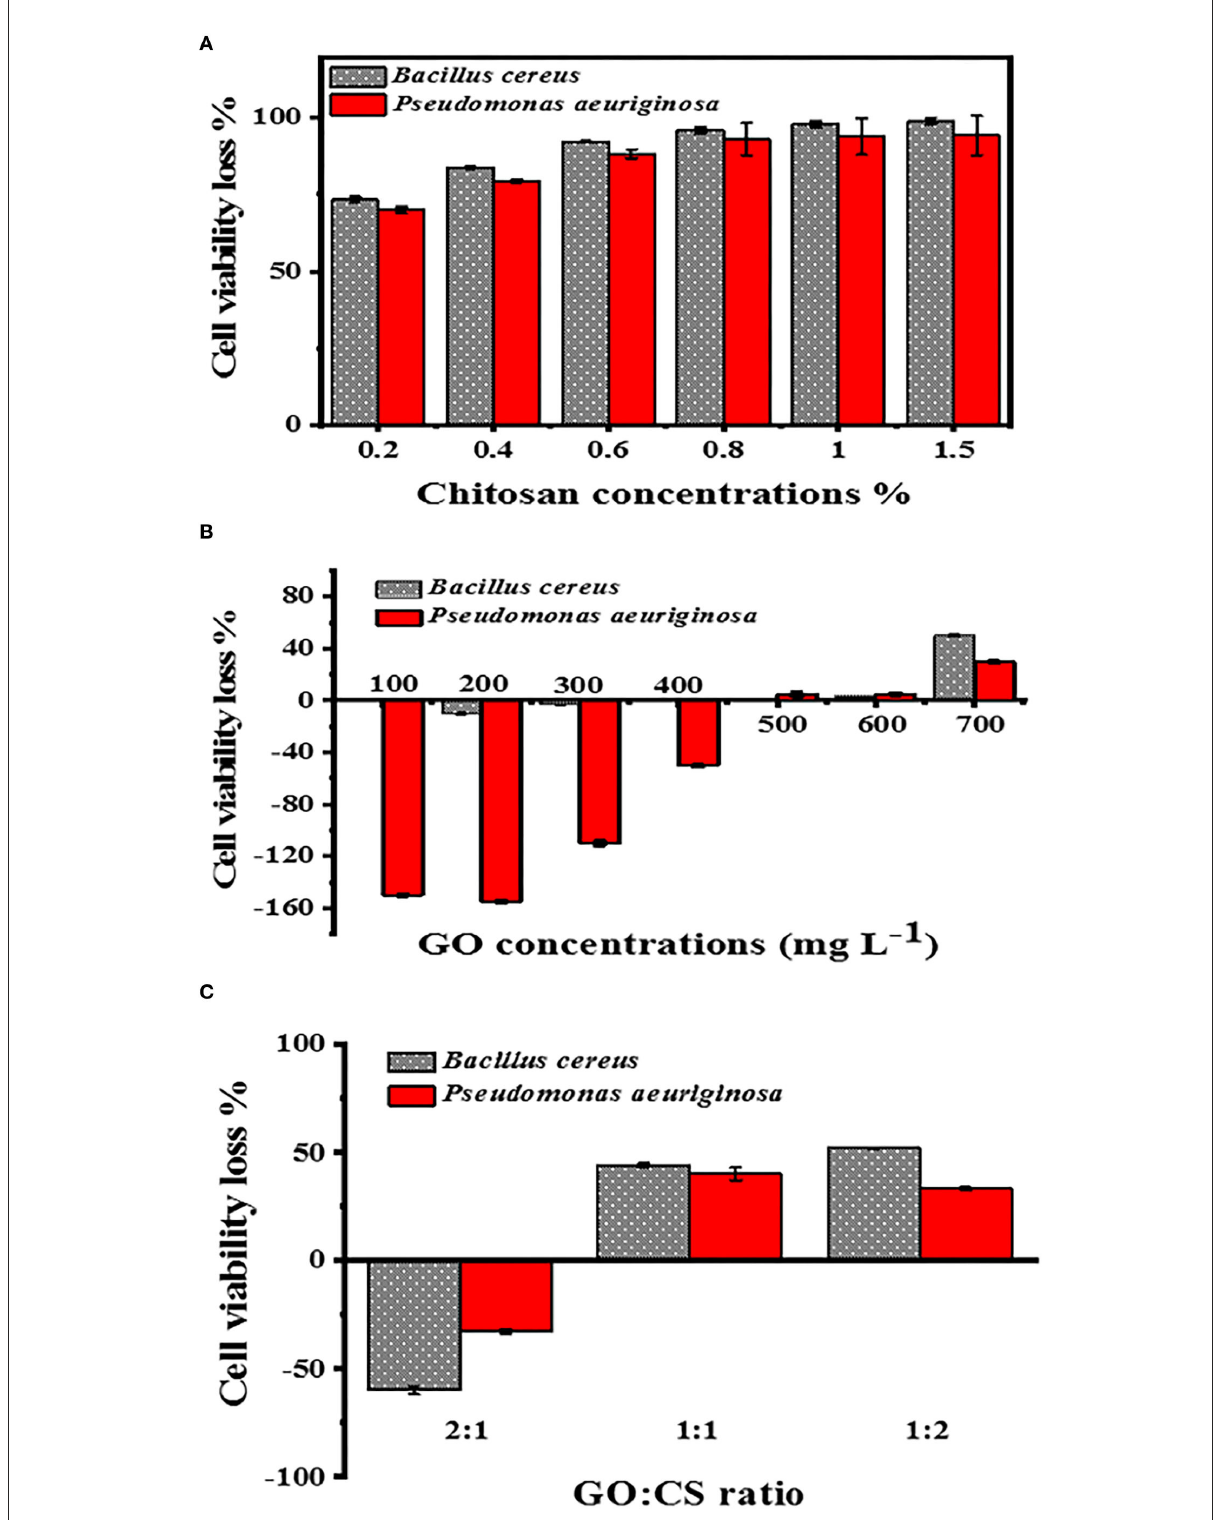
FIGURE5 Cell viability loss determination at different concentrations of CS (A) , with different concentrations of GO (B) , and different ratios of GO:CS (C)